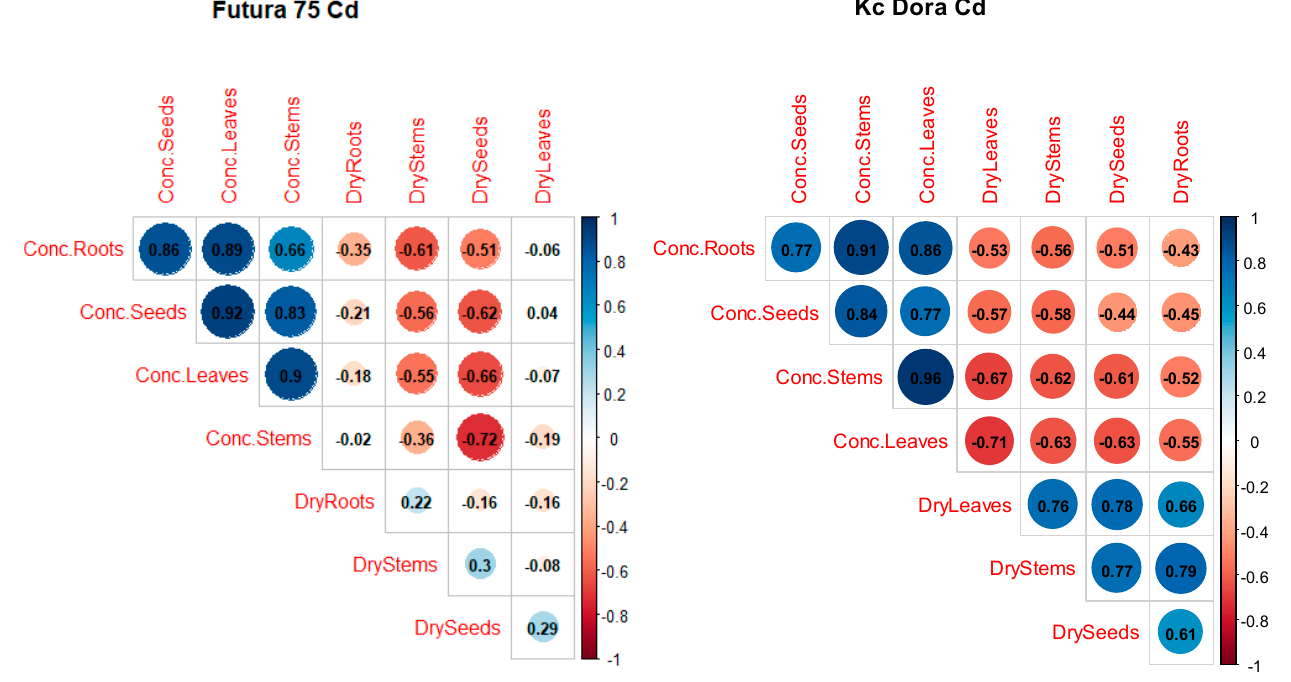
Figure 5. Correlation matrix of Cd of Futura75 and KC Dora, using as the variable the biomass yield of roots, stems, leaves, and seeds, and the concentration of the heavy metal measured in each part of the plant. The numbers within the circles represent the Pearson correlation coefficient.